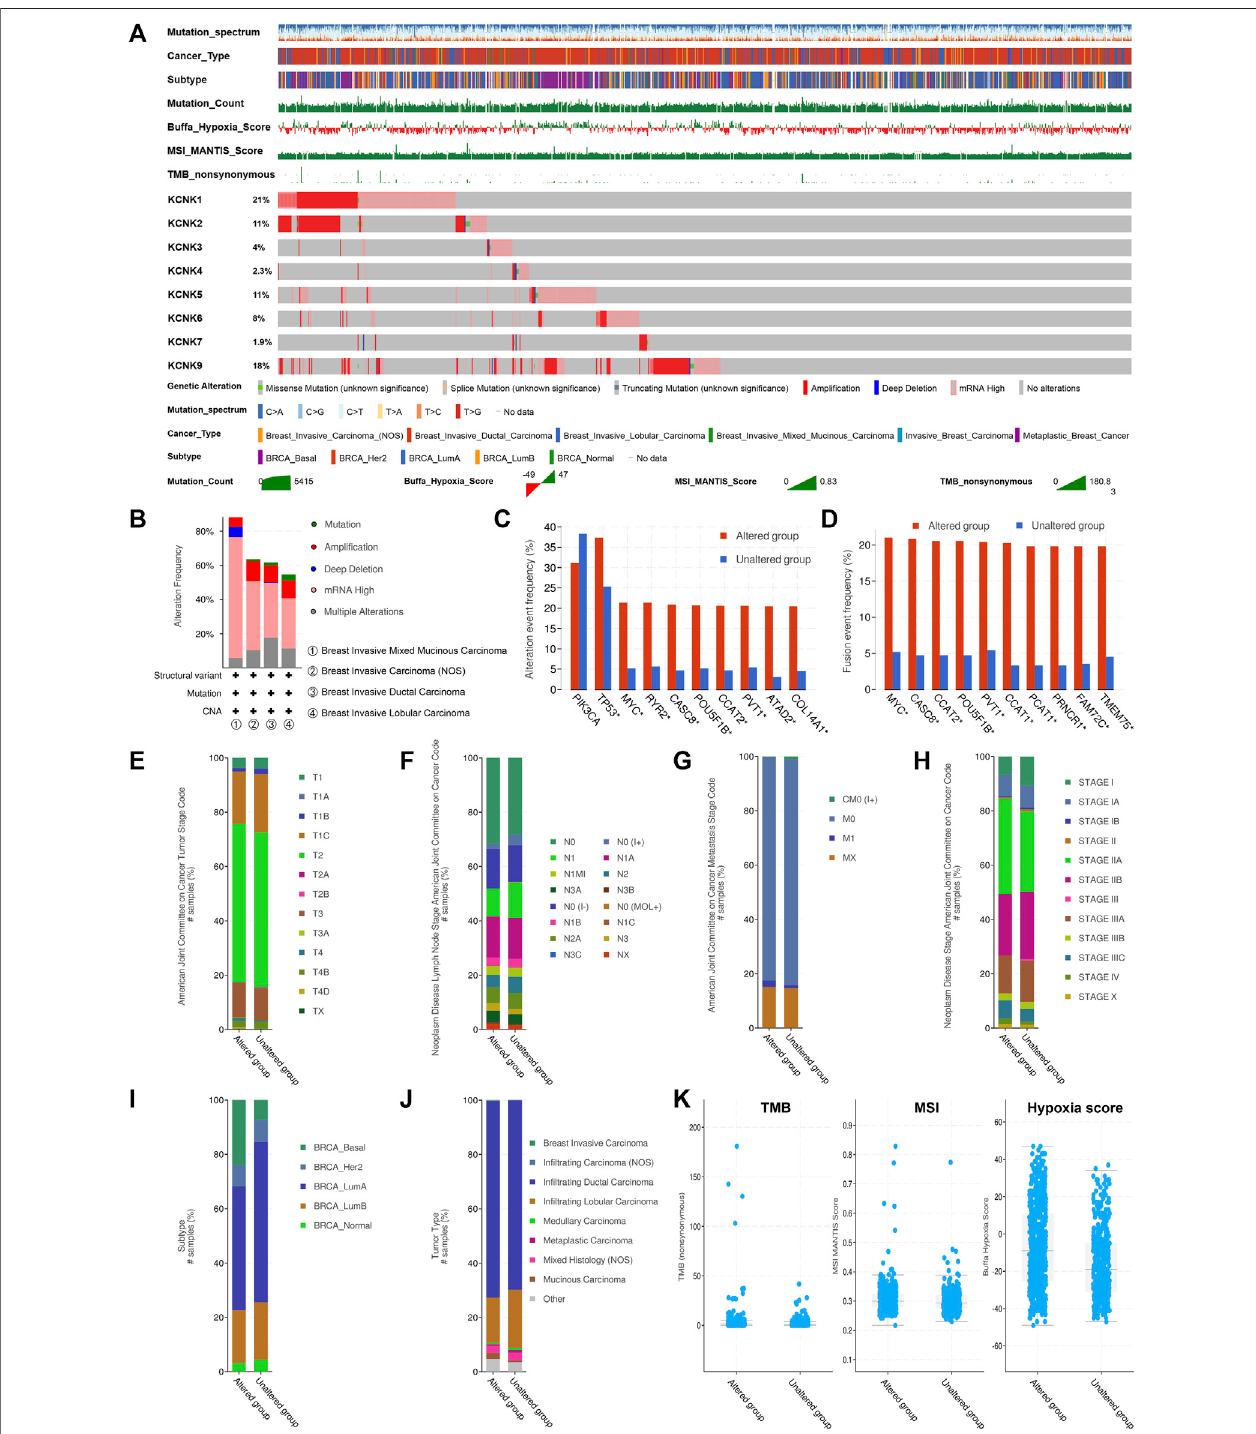
FIGURE 2 | Genomic alteration landscape of KCNK gene family in breast cancer. (A) The genomic alteration of KCNK genes in TCGA cohort. Oncoplot was used for display. (B) The alteration frequency of KCNKs in different breast cancer pathology types. (C) The correlation between the alteration of KCNKs and the alteration of several robust oncogenes in breast cancer development. (D) The correlation between KCNKs and fusion genes. (E – J) The relationship between the alteration of KCNK genesandtheclinicalcharacteristics ofbreastcancer. (K) TherelationshipbetweenthealterationofKCNK genesandtumor mutationburden (TMB),microsatellite instability (MSI), and hypoxia score in breast cancer.